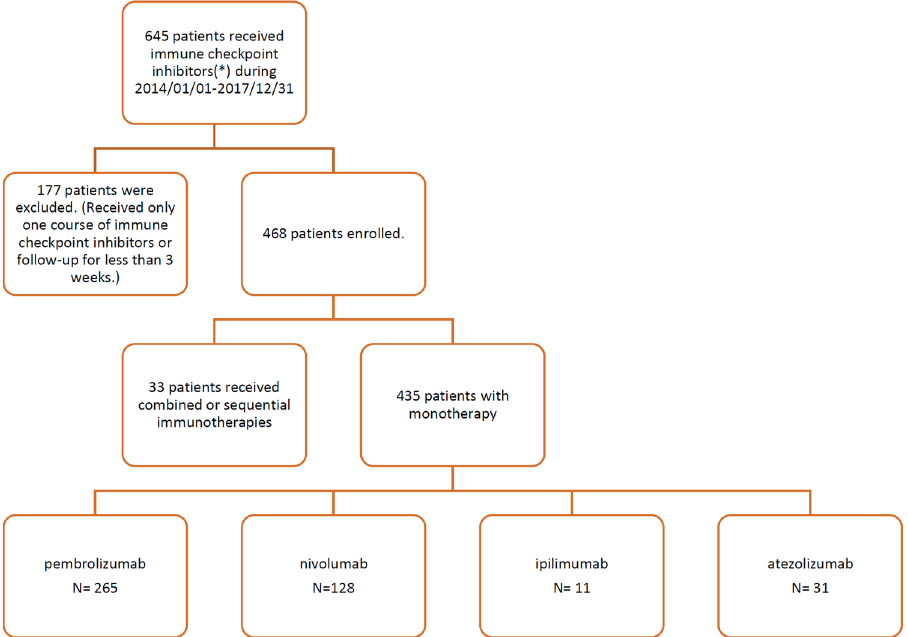
Figure 1. Study protocol and patient enrollment. Immune checkpoint inhibitors: pembrolizumab, nivolumab, ipilimumab,